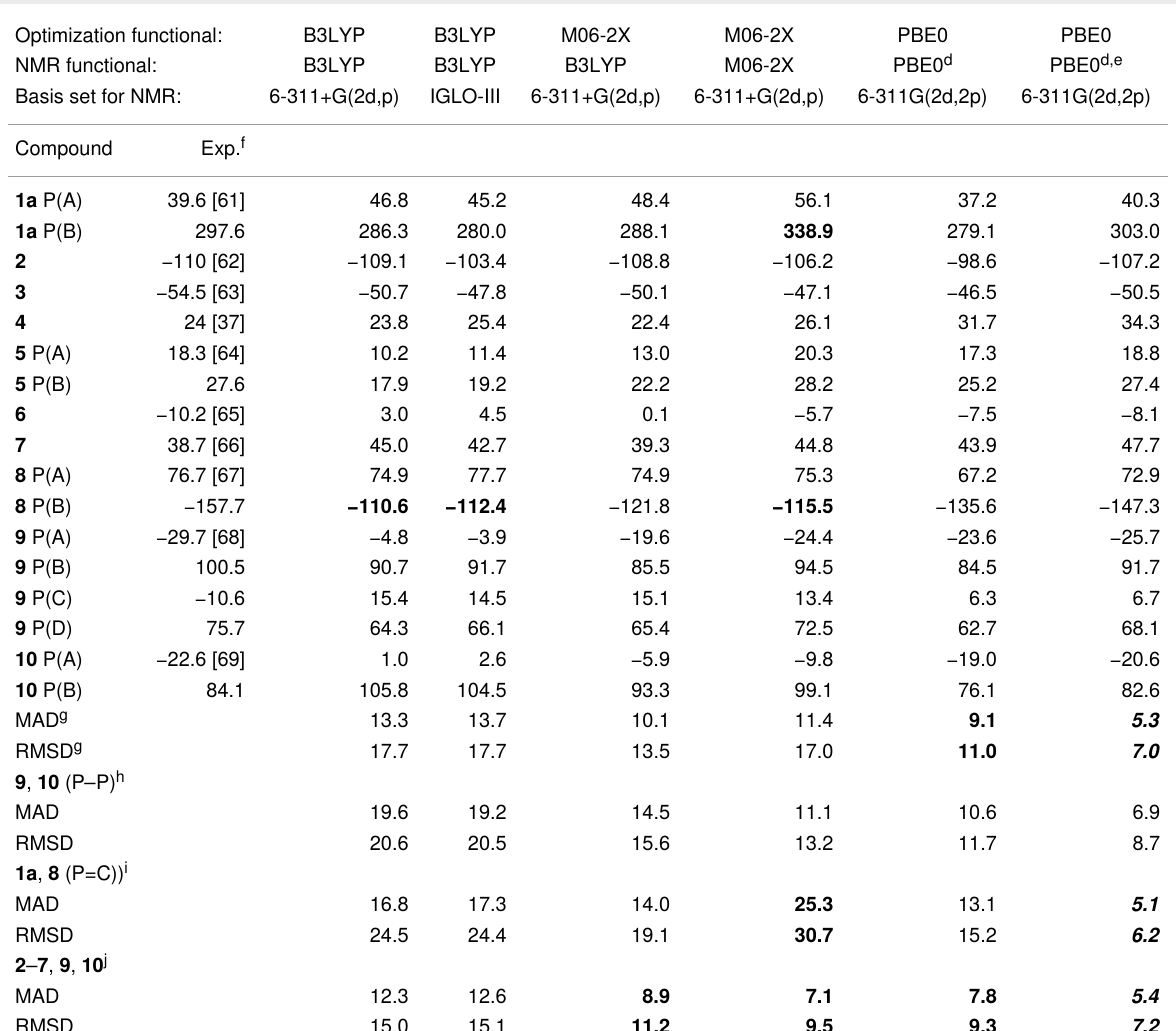
Table 2: Experimental a and scaled b 31 P NMR chemical shifts c for Figure 4